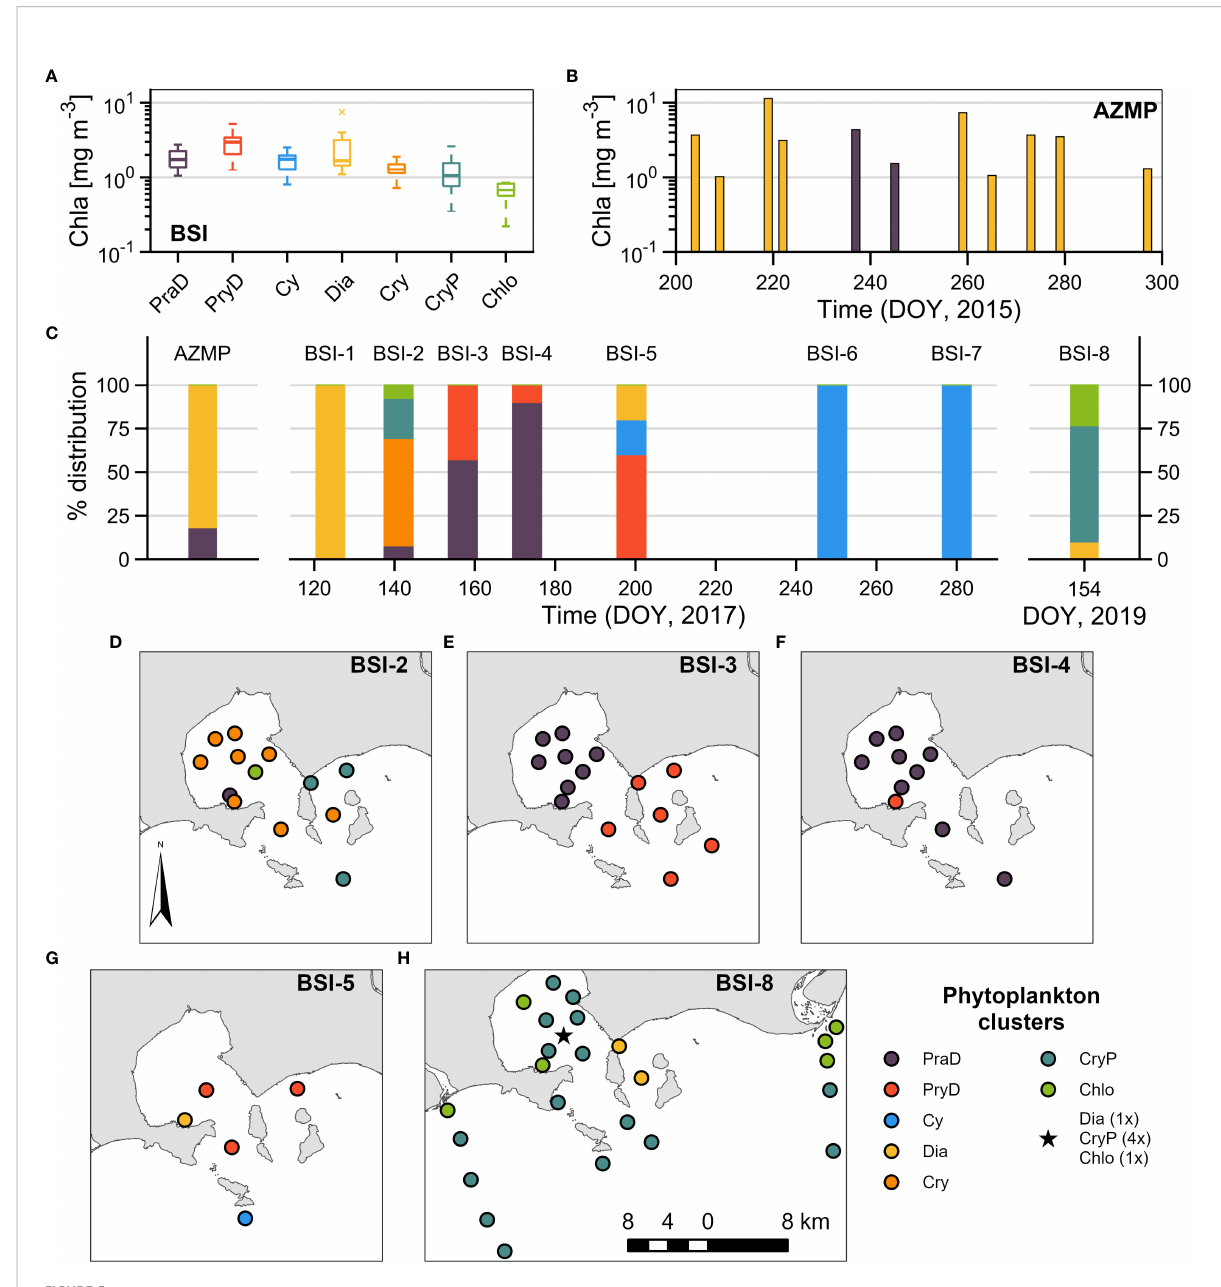
FIGURE 5 Temporal and spatial variability of the phytoplankton clusters. (A) Boxplots showing the variability of Chla for each cluster, for the Bay of Sept- I ̂ les (BSI). (B) Bars showing the temporal variability of Chla in the AZMP buoy station (DOY = Day of Year). The color of the bars corresponds to the class of phytoplankton clusters. (C) Relative distribution of phytoplankton clusters for AZMP and for the temporal series in BSI (BSI-1 to 8; Table 1). (D – H) Spatial distribution for each campaign that presented noticeable variability of phytoplankton